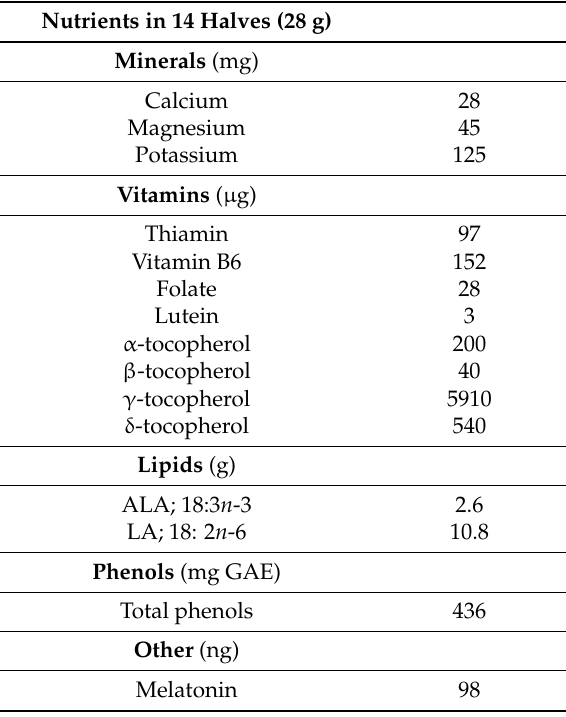
Table 1. Selected nutrients in